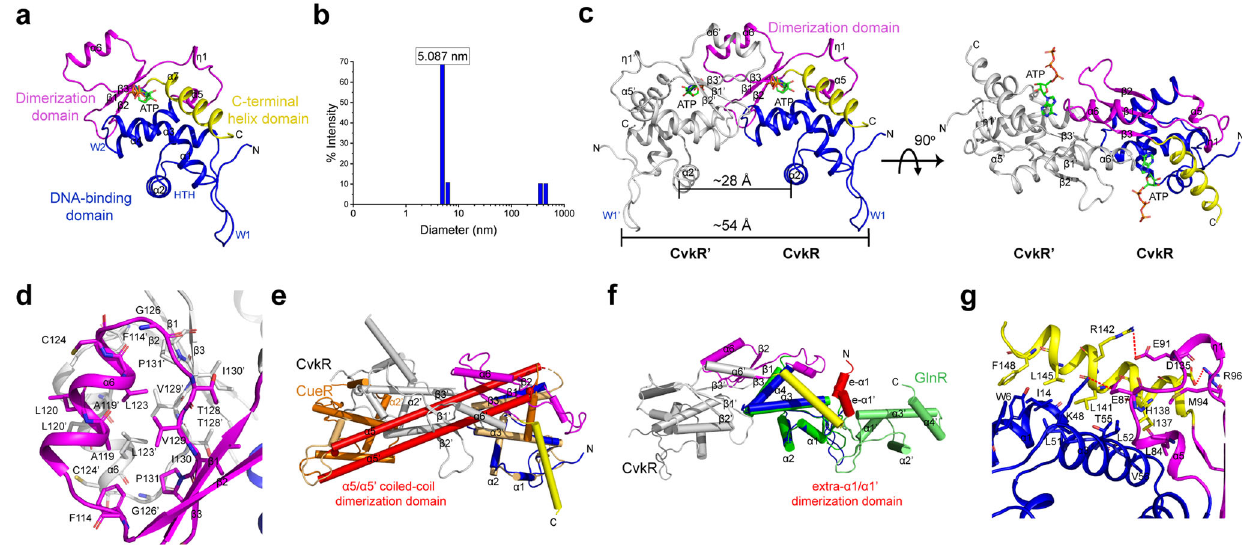
Fig.7|StructuralanalysesofCvkR.a OverallstructureoftheCvkR-ATPcomplex. The DNA-binding, dimerization, and putative effector-binding C-terminal helix domains are shown in blue, magenta, and yellow, respectively. The typical helix- turn-helix (HTH) and two “ wing ” loops W1 and W2 in the DNA-binding domain are indicated. The ATP ligand is represented in green stick and colored by the atom type. b Dynamic light scattering analysis of the average diameter of native CvkR protein measured at 25°C. The data are representative from three independent experiments. c CartoonrepresentationoftheCvkRhomodimer.Theothersubunit is shown in white. The bulk of the dimerization interface is formed by three anti- parallel β -strands( β 2- β 1- β 3)andoneshort α -helix( α 6)fromthetwosubunitsinthe dimer.ThedistancesbetweentwoDNA-interactinghelices α 2/ α 2 ’ andbetweentwo W1 loops W1/W1 ’ are measured and labeled, respectively. d The dimerization